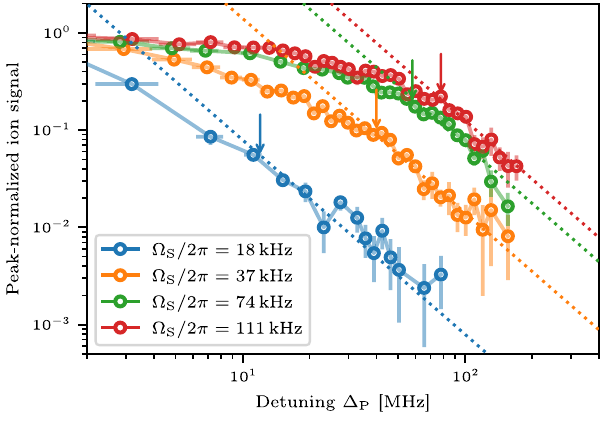
Fig. 4 Scaling behavior of the interacting spectra. The measured spectral density (dots) approaches the expected ∣ Δ P ∣ − 2 scaling (dotted lines) for large detuning. This scaling indicates the occurrence of predominantly localized states. The arrows indicate the detuning where the transition toward ∣ Δ P ∣ − 2 scaling sets in. This corresponds to the dashed lines in Fig. 3. For increasing Rabi frequency Ω S and thus increasing seed atom number the onset of the localization--delocalization crossover shifts to larger detunings. Horizontal error bars re fl ect energy bin sizes for the evaluation. Vertical error bars denote the standard error of the mean of the ion signal